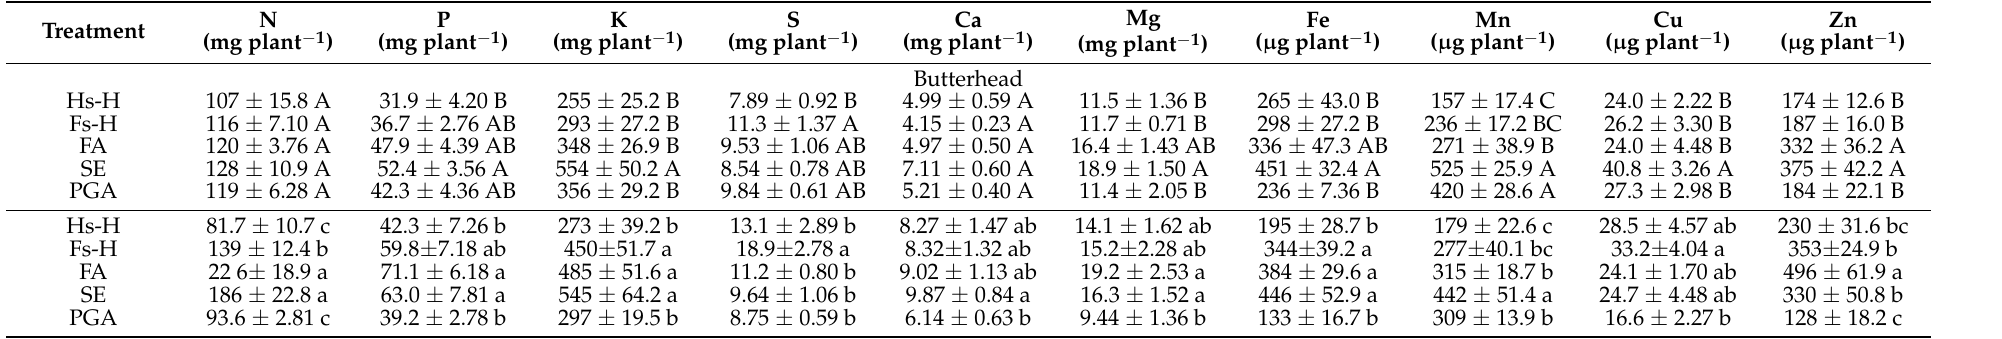
Table 4. Macro and micronutrient content in the shoot of butterhead and red oak-leaf lettuce. Data represent mean ± SD ( n = 3). Means within each column followed by different uppercase and lowercase letters are significantly different for butterhead and red oak-leaf ( α = 0.05).